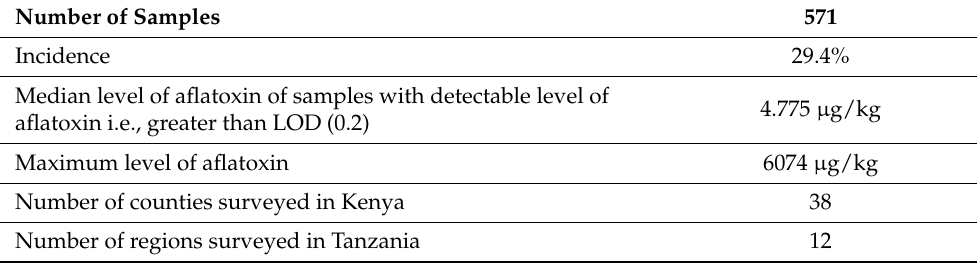
Table 1. Summary statistics for aflatoxin measurements for the entire survey. “Incidence” is the per- centage of samples that had detectable levels of aflatoxins, whereas “level” refers to the concentration of aflatoxin among all samples with detectable levels of aflatoxin (level of detection, LOD 0.2 µ g/kg). Number of Samples 571 Incidence 29.4% Median level of aflatoxin of samples with detectable level of 4.775 µ g/kg aflatoxin i.e., greater than LOD (0.2) Maximum level of aflatoxin 6074 µ g/kg Number of counties surveyed in Kenya 38 Number of regions surveyed in Tanzania 12 Observed proportion of samples with detectable levels of aflatoxin from different counties of Kenya and regions of Tanzania are shown in Figure 1. Incidences for regions from which more than 4 samples were collected are